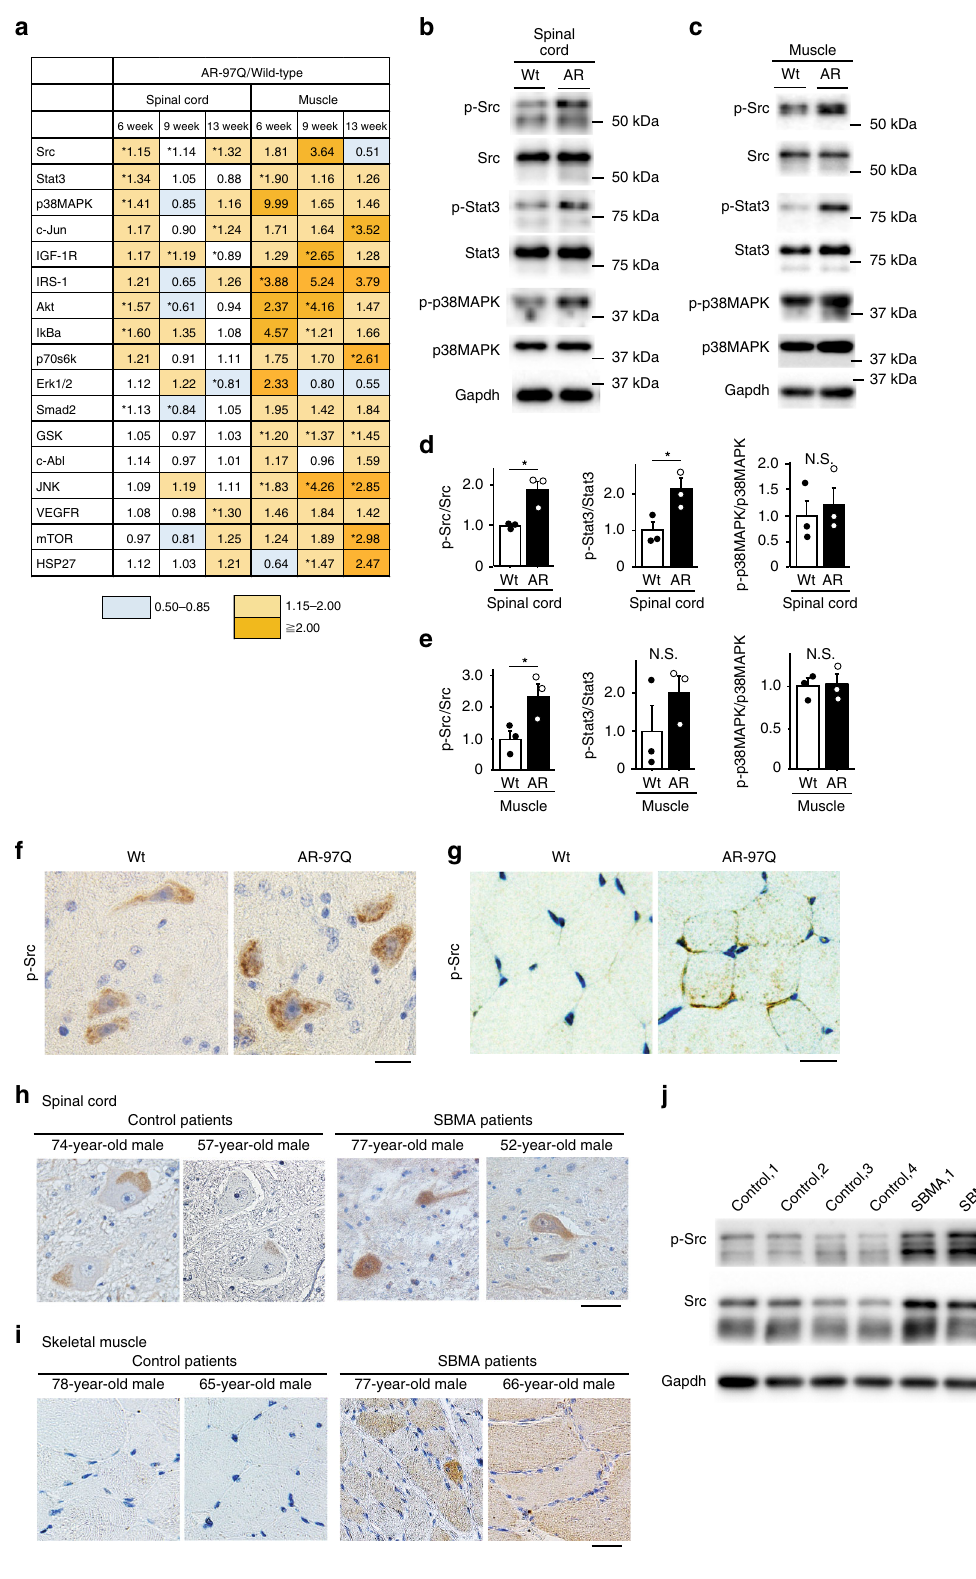
analyses showed that mRNA levels of Src in 97Q cells were not signi fi cantly different from those in 24Q cells, suggesting that AR regulates Src activity at a post-translational phase (Fig. 2f, g). neurons from patients with SBMA displayed an increased level of